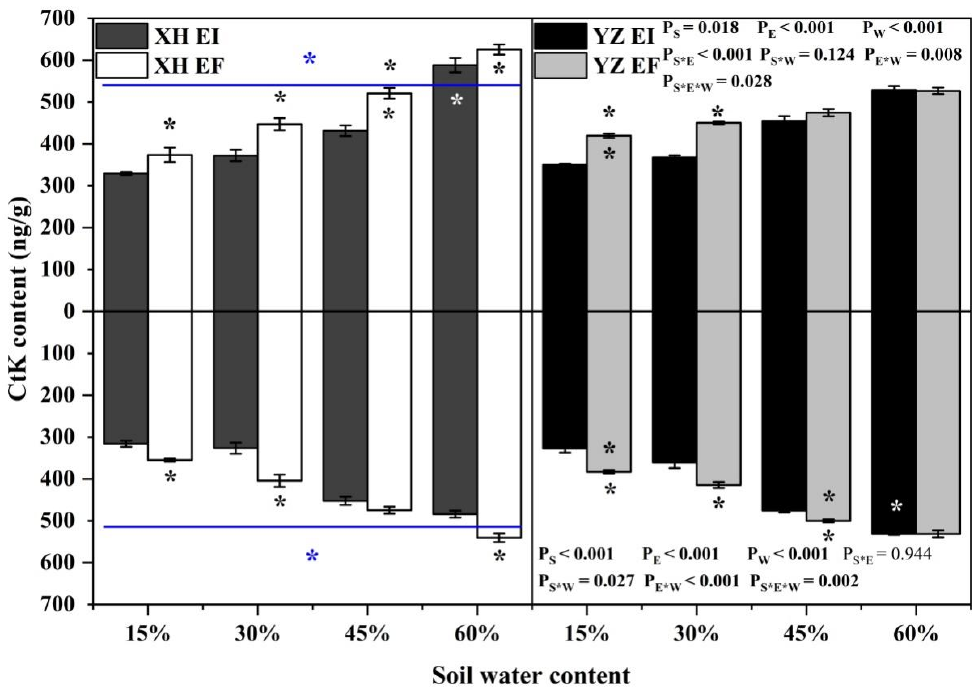
Figure 4. The CtK content of A. inebrians seedlings shoots and roots from XH(W) and YZ(D) seeds under various soil water content (ng/g). Upwards and downwards bars represent the value of shoot and root part, respectively. The asterisk (*) above/below error bars means significant differ- ence ( p < 0.05) between EI and EF under the same soil water content. White/black * in the white, black and gray bars indicates significant difference ( p < 0.05) between Xiahe and Yuzhong maternal habitat type of EF/EI grasses. The blue * above/below full blue line indicates significant difference ( p < 0.05) between Xiahe and Yuzhong maternal habitat type.